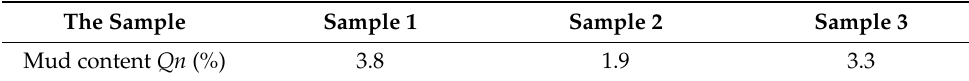
Table 5. Mud content test results of Embodiment